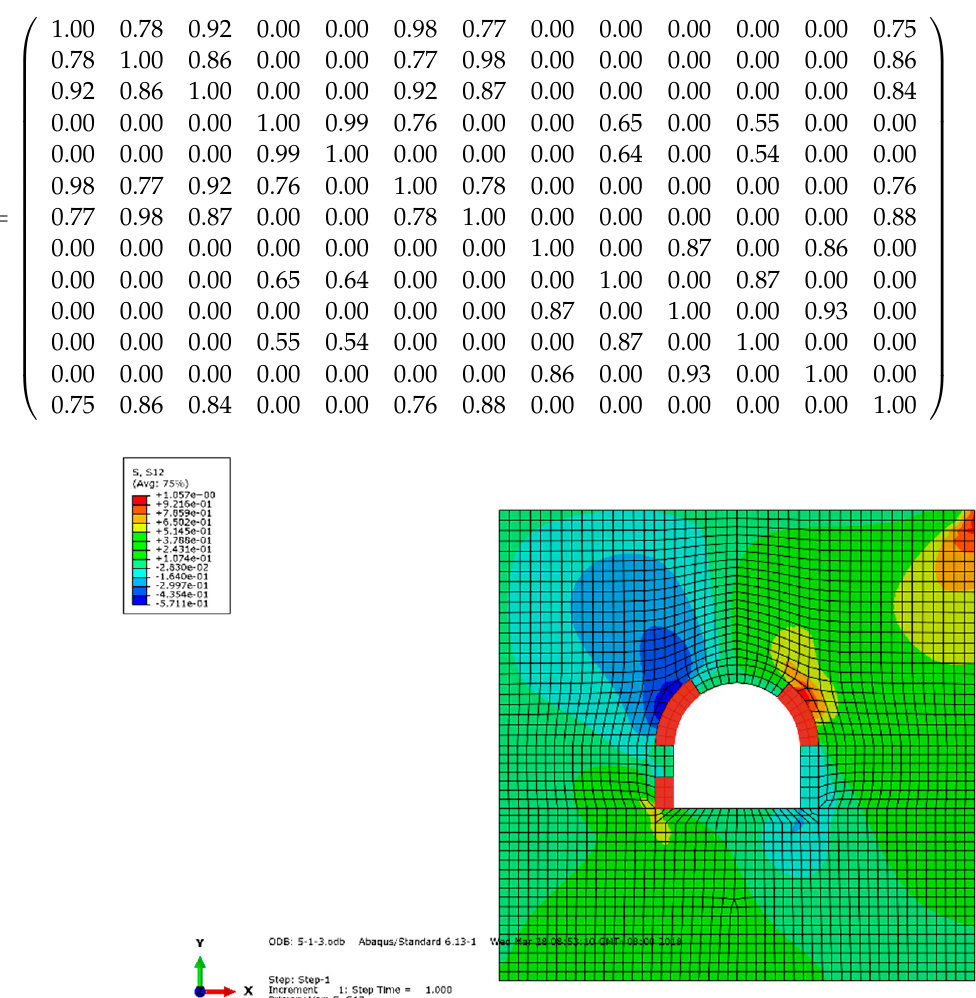
Figure 11. Final failure parts when λ = 0.5.